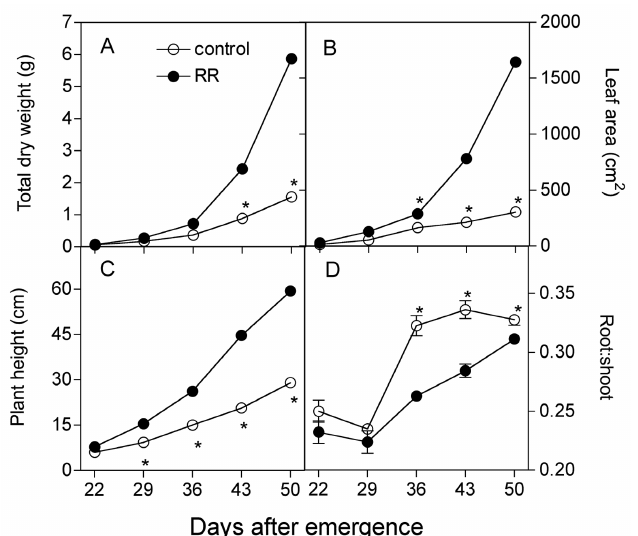
Fig. 1 - Growth parameters measured at weekly intervals from day 22 to the end of the experiment in both control and root-restrict- ed (RR) plants: total dry weight (A), leaf area (B), plant height (C) and root:shoot ratio (D). * indicates significantly different values for P≤0.05 (n=5), when means were separated by Dun- can’s test.